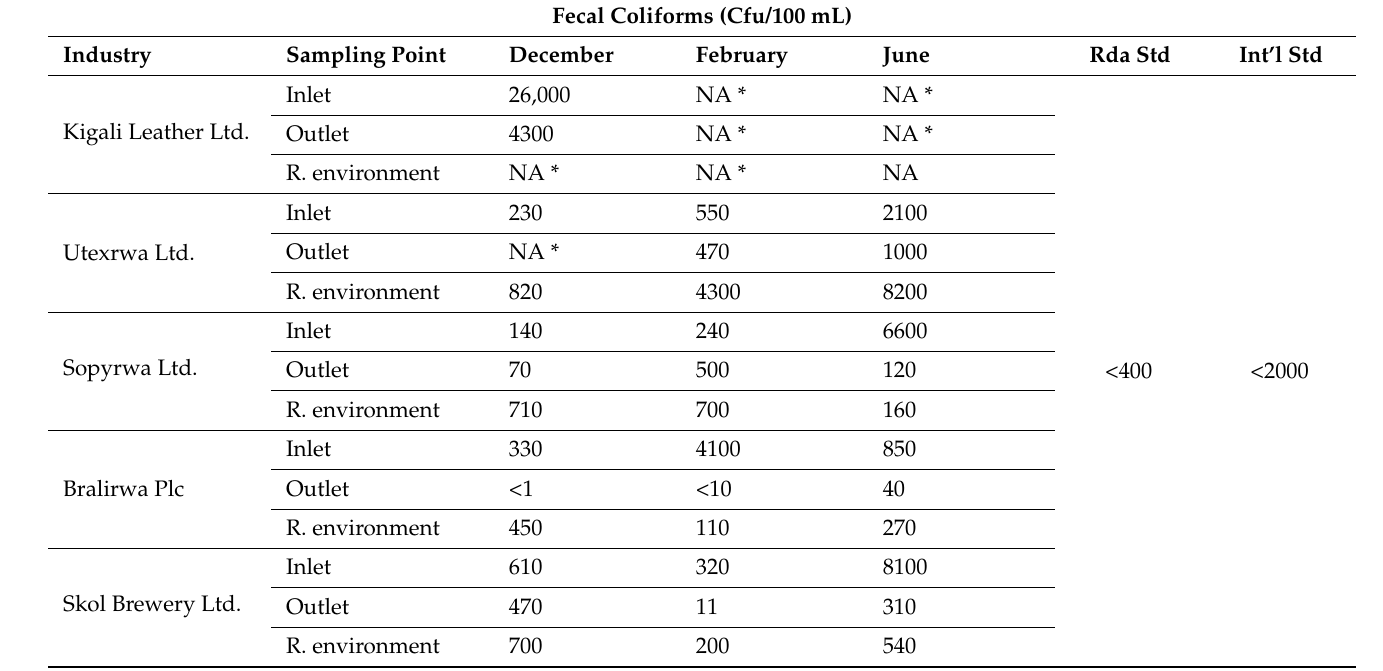
Table 8. Fecal coliform results for the selected industries. Fecal Coliforms (Cfu/100